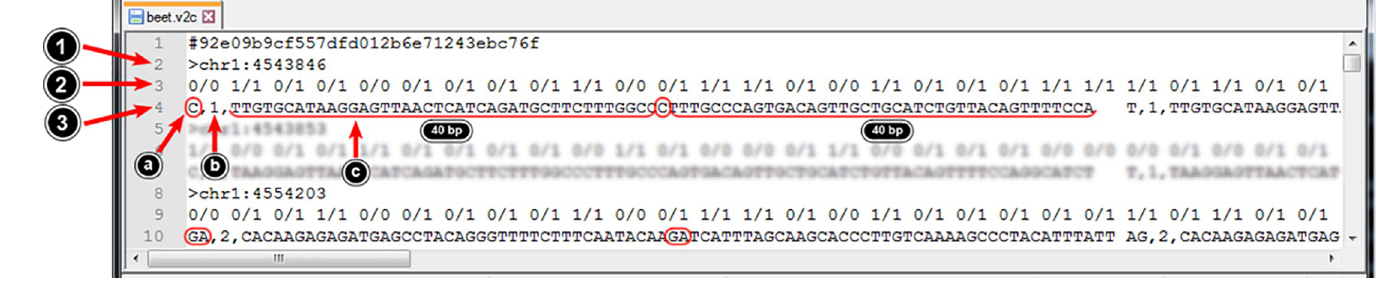
Fig 2. The V2C file format–file elements are marked with arrows and described in the